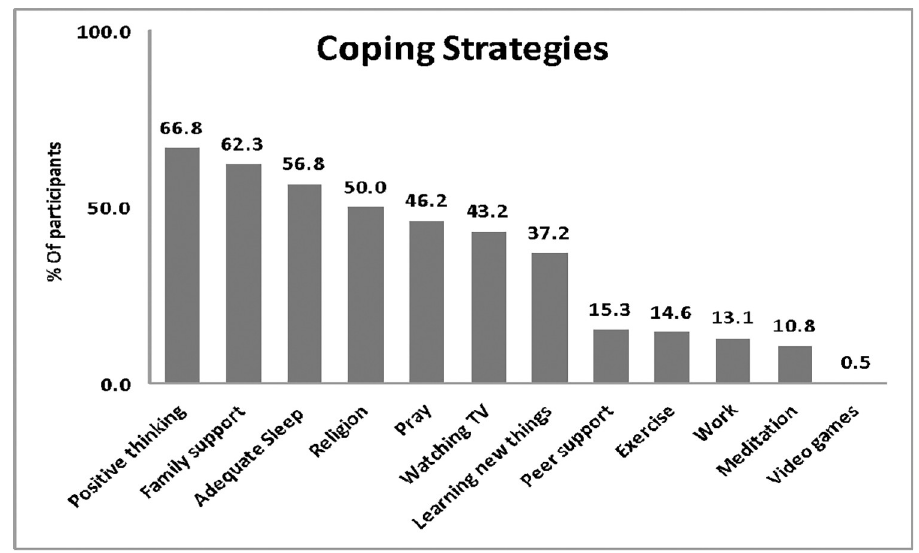
Fig 3. Coping strategies reported by the study participants during the COVID-19